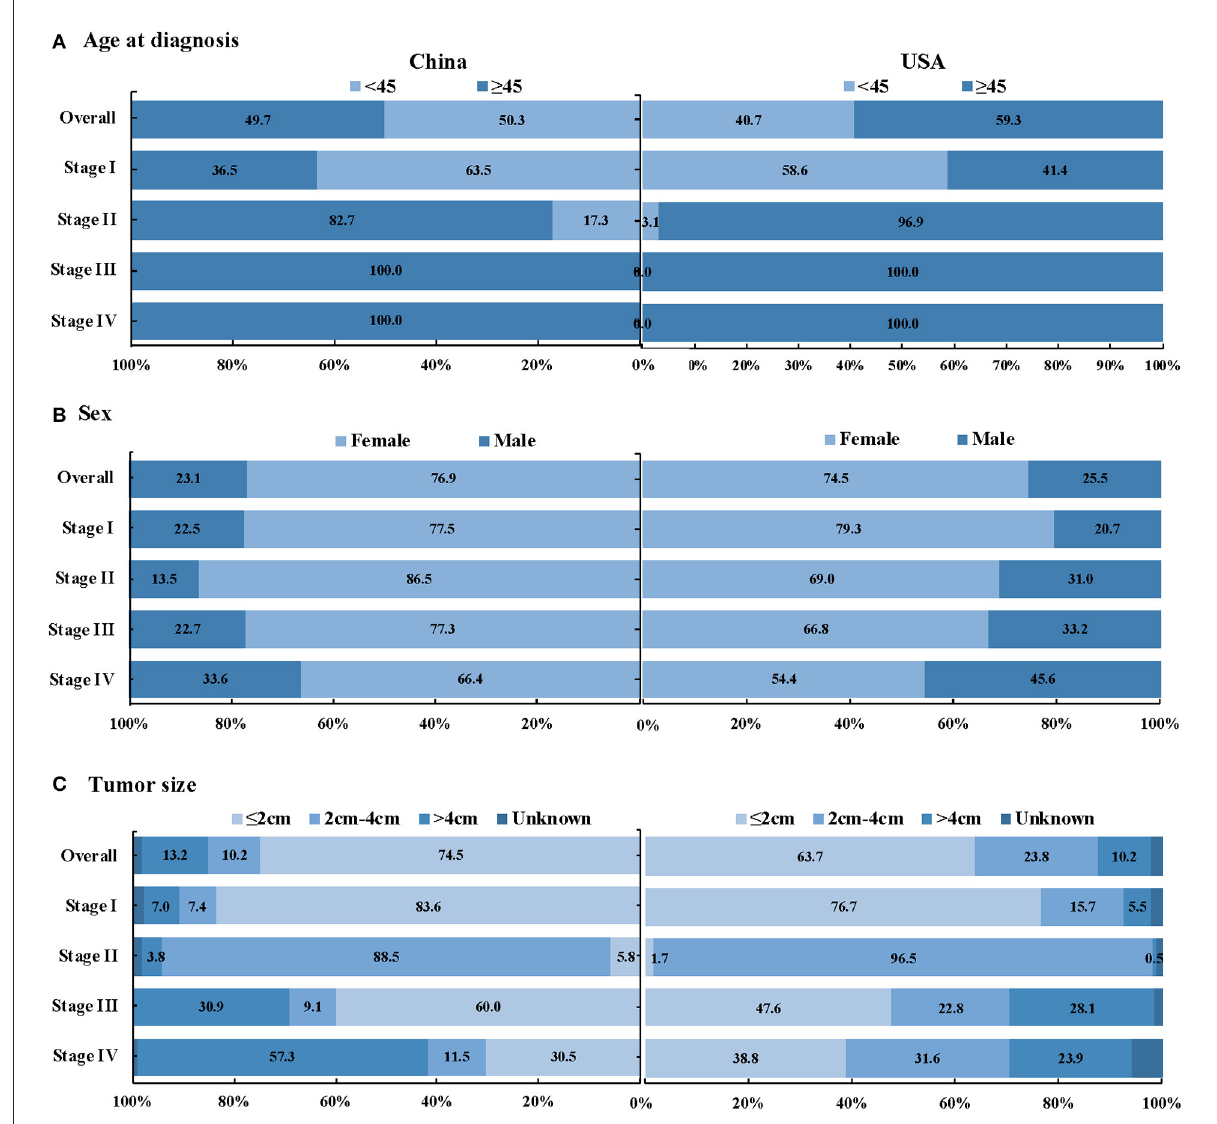
FIGURE2 Stage distribution of DTC patients between the study in China and SEER database in the USA, by age at diagnosis, sex and tumor size (A) Age at diagnosis, (B) Sex, and (C) Tumor